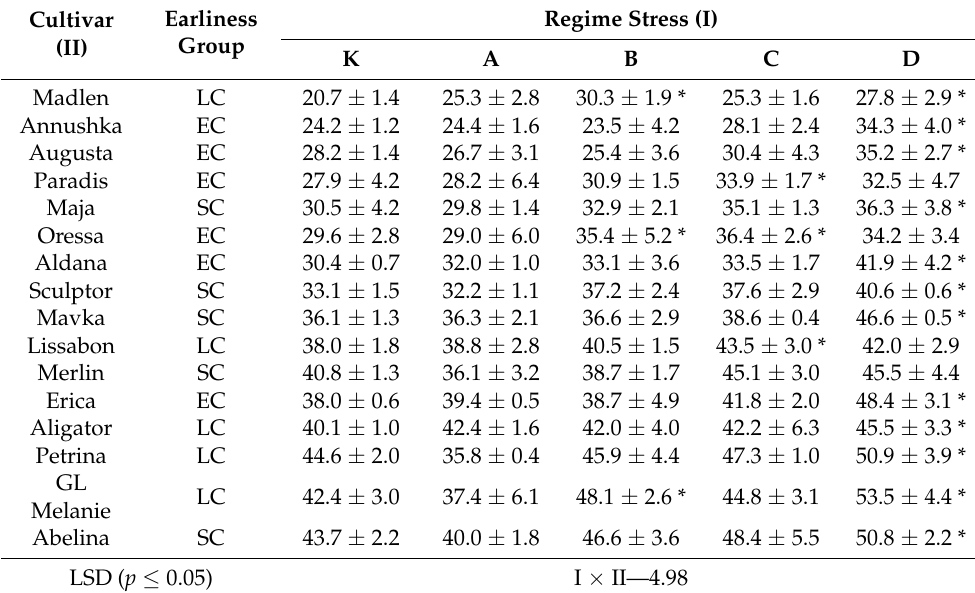
Table 3. Yield of soybean seeds depending on cultivar and stress regime (interaction). ± SD (n = 6).